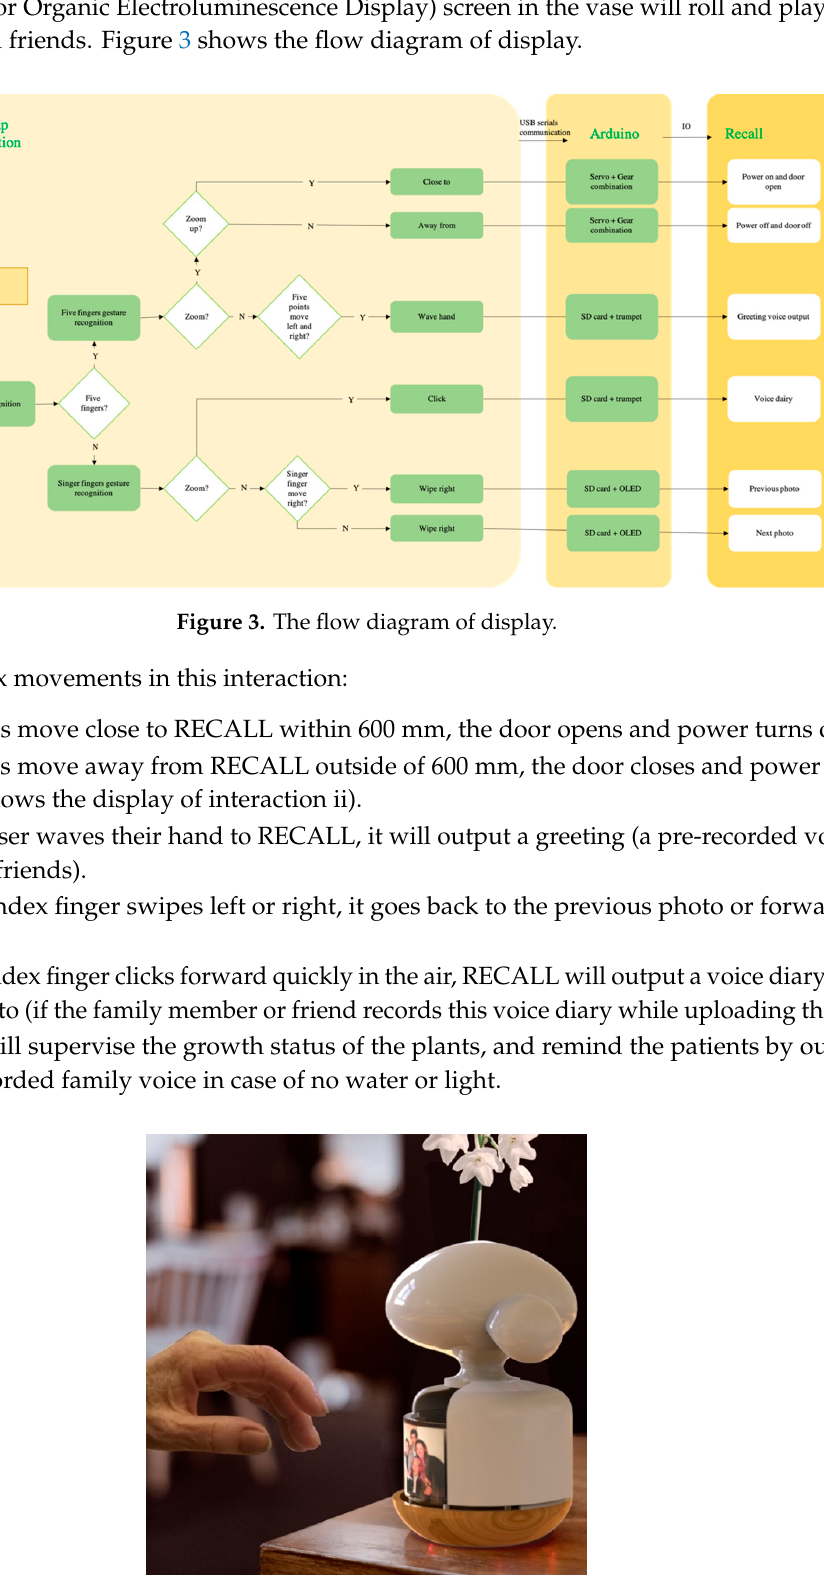
Figure 4. Interaction demonstration.